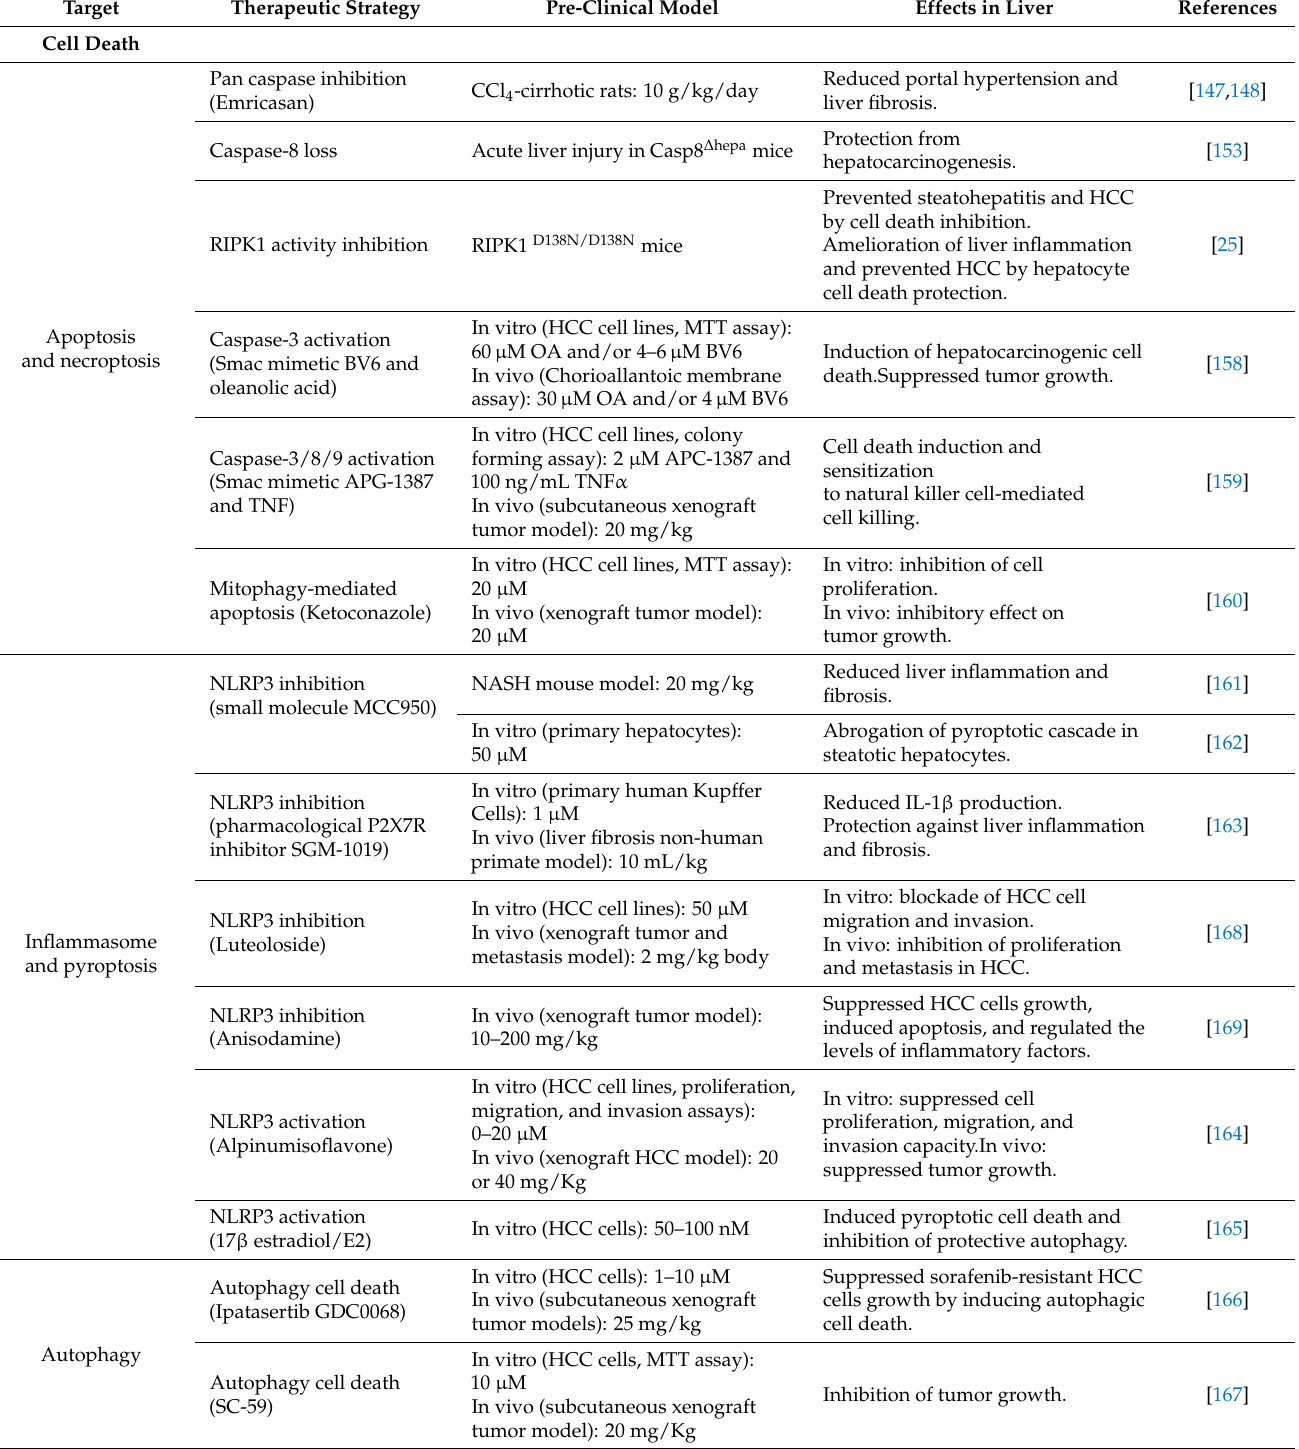
Table 1. Therapeutic strategies targeting cell death and tumor